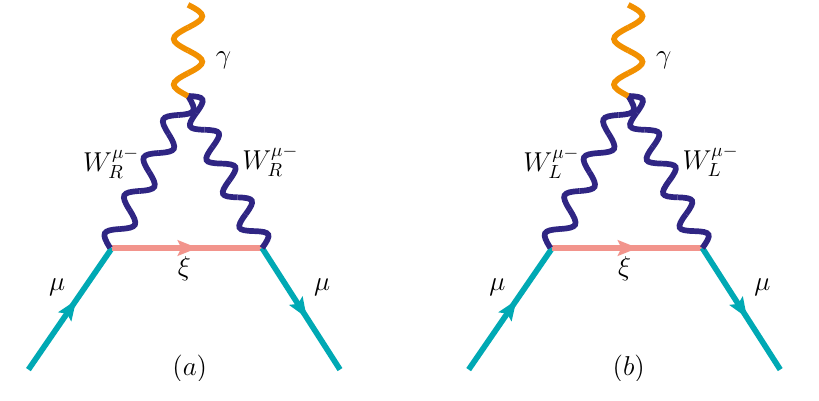
Figure 1 . Feynman diagrams for the interaction of singly charged vector bosons: in left-panel due to the mediation of singly charged right-handed gauge boson W R with heavy neutrinos and in right-panel due to the mediation of singly charged left-handed gauge boson W L with exchange of heavy neutrinos. The W L mediated diagram with exchange of heavy neutrinos gives sizeable contribution in ISS